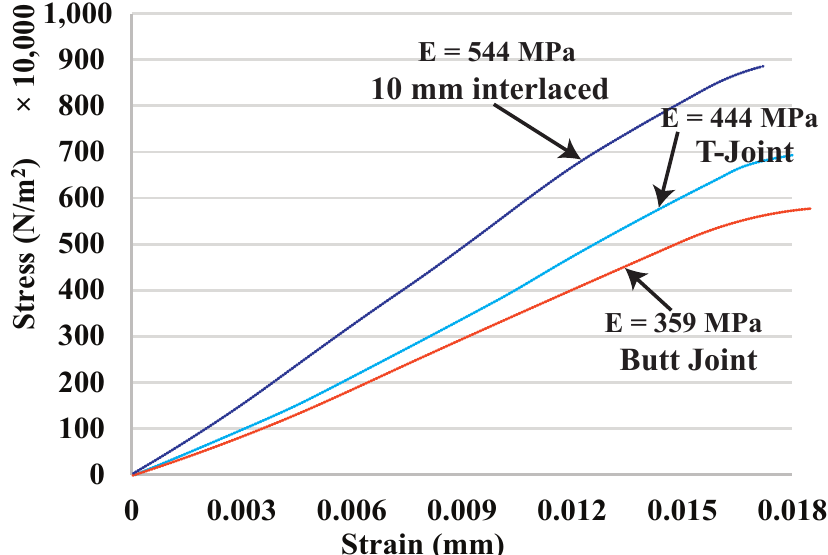
Figure 12. Tensile test curves for different joint configurations.